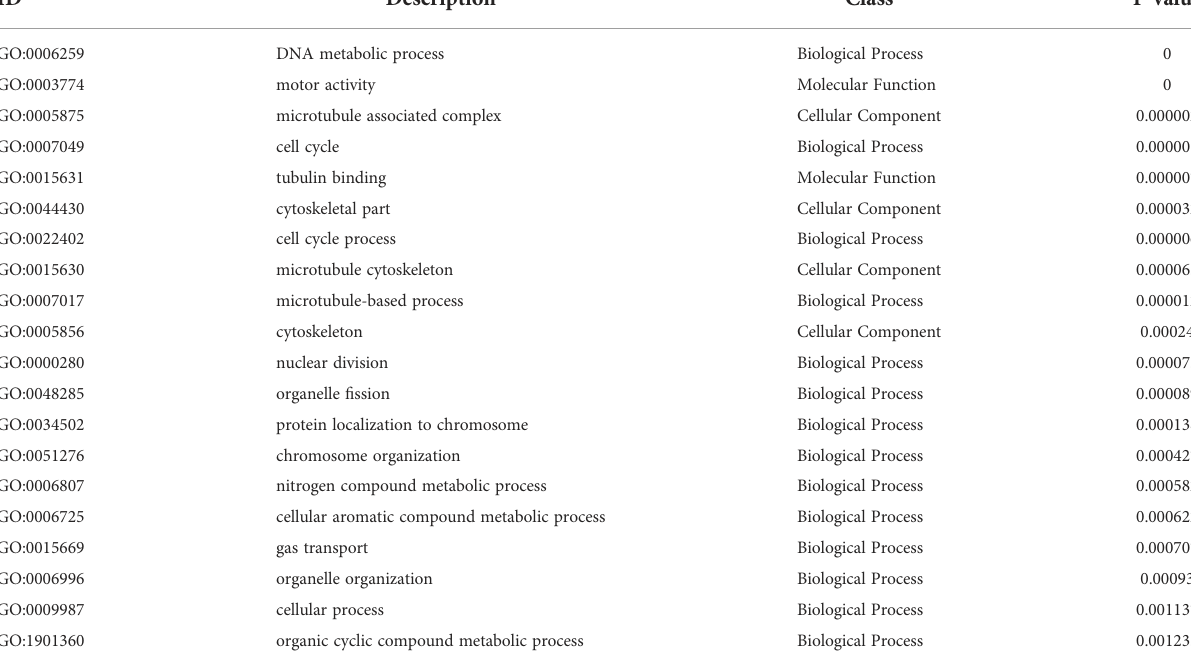
TABLE 6 ID, description, class and speci fi c P-value of Top 20 GO terms at 1 st post challenge day.